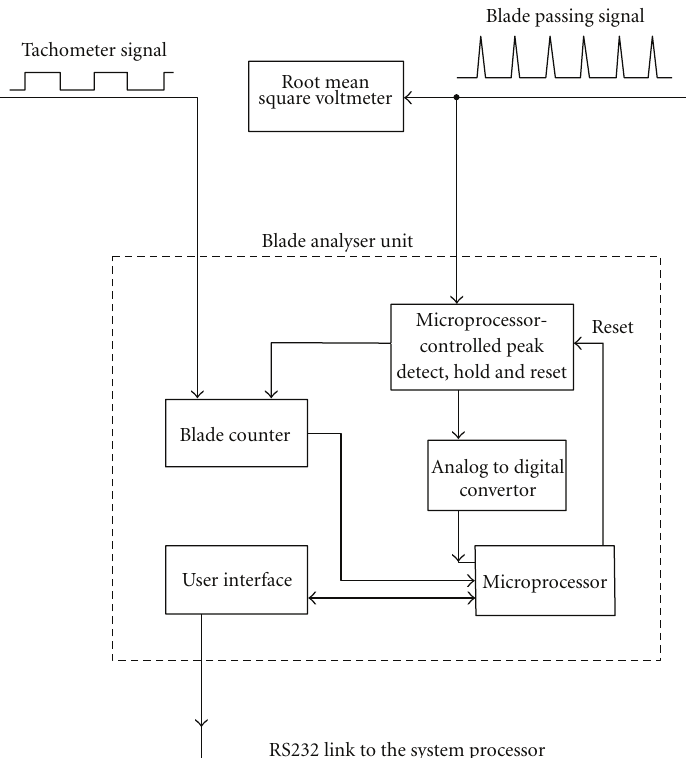
Figure 3: The blade analyser unit developed by Killeen et al. [20] and used to measure individual pulse heights, schematic block diagram. complete revolution of the bladed disc. The microprocessor compares the number of pulses acquired with the known number of blades on the disc. If the two numbers are the same, it assumes no missed pulses, and the pulse heights pass to a user interface where they are output in RS-232 format as a string of blade numbers versus pulse